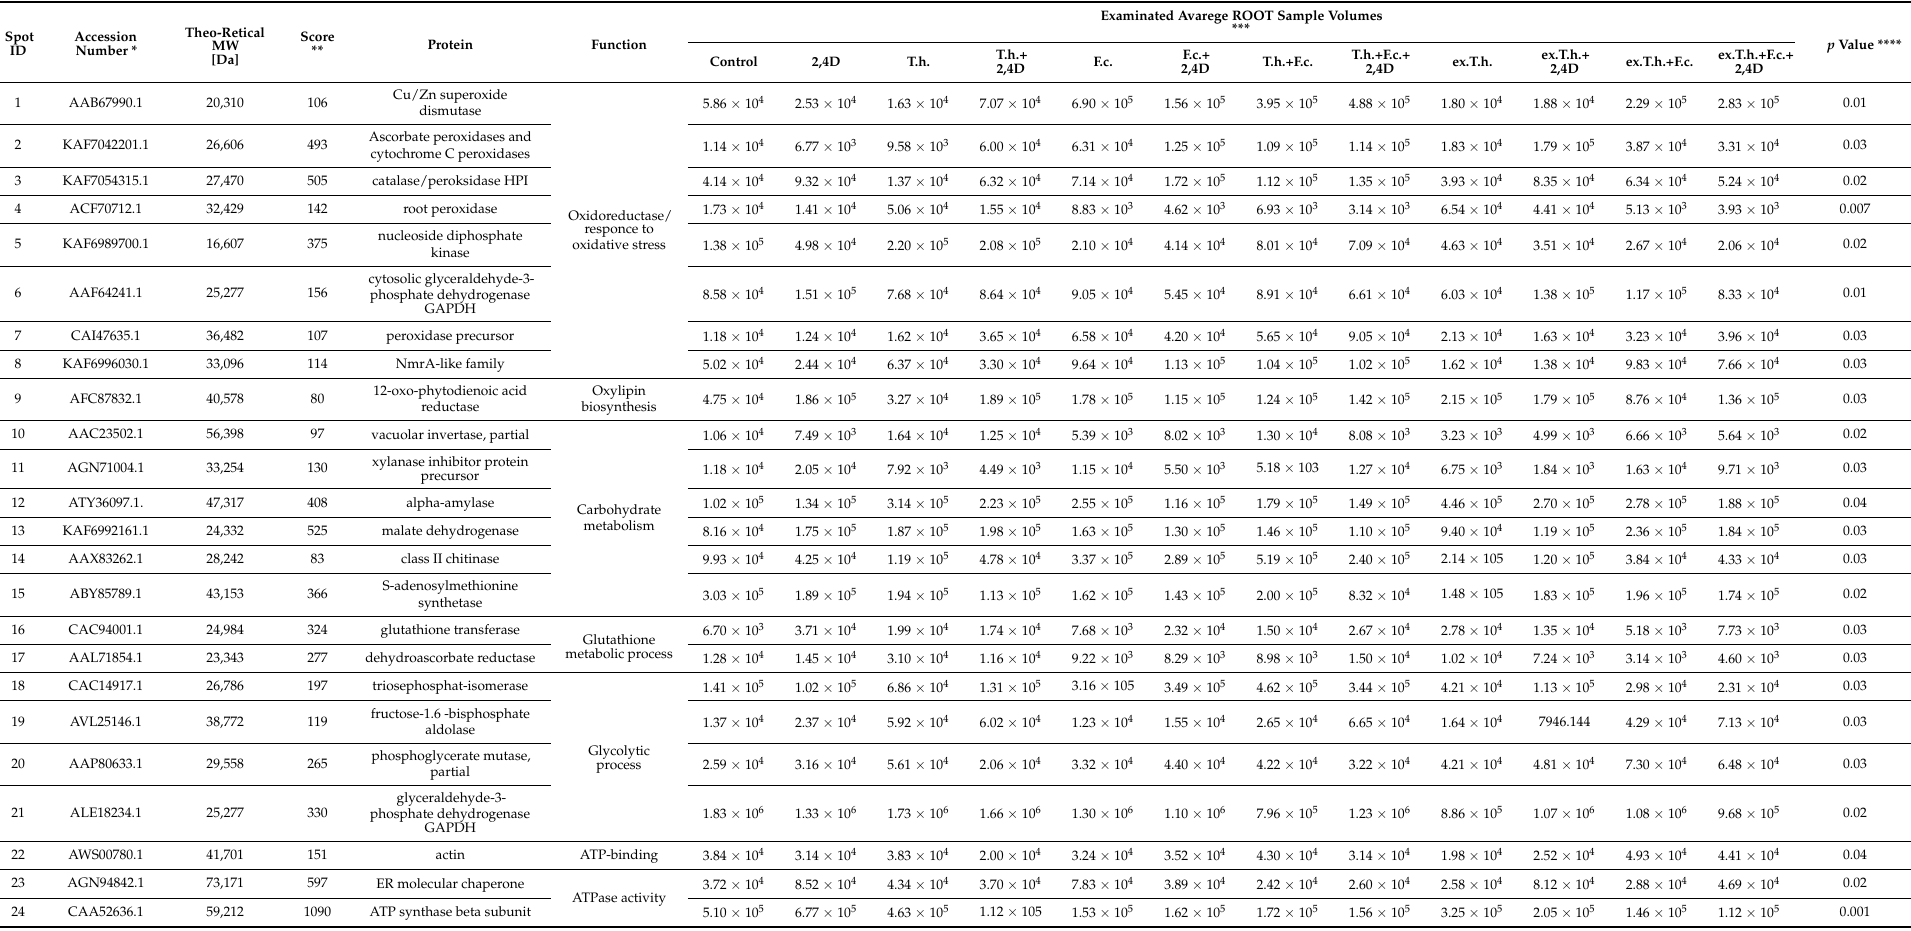
Table 1. Changes in average protein spot volumes, after SDS-Page electrophoresis and trypsin digestion analyzed by MALDI TOF/TOF identified by Mascot from root and shoot material of wheat, analyzed after 7 days of cultivation (T. h.— T. harzianum inoculated wheat seeds, F. c.— F. culmorum inoculated wheat seeds, ex. T. h.— T. harzianum extracellular metabolites treated wheat